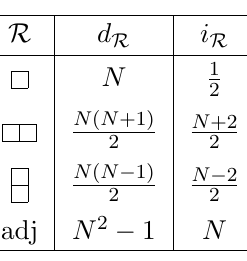
Table 4 . Dimensions and indices of the fundamental, symmetric, anti-symmetric and adjoint representations of SU( N